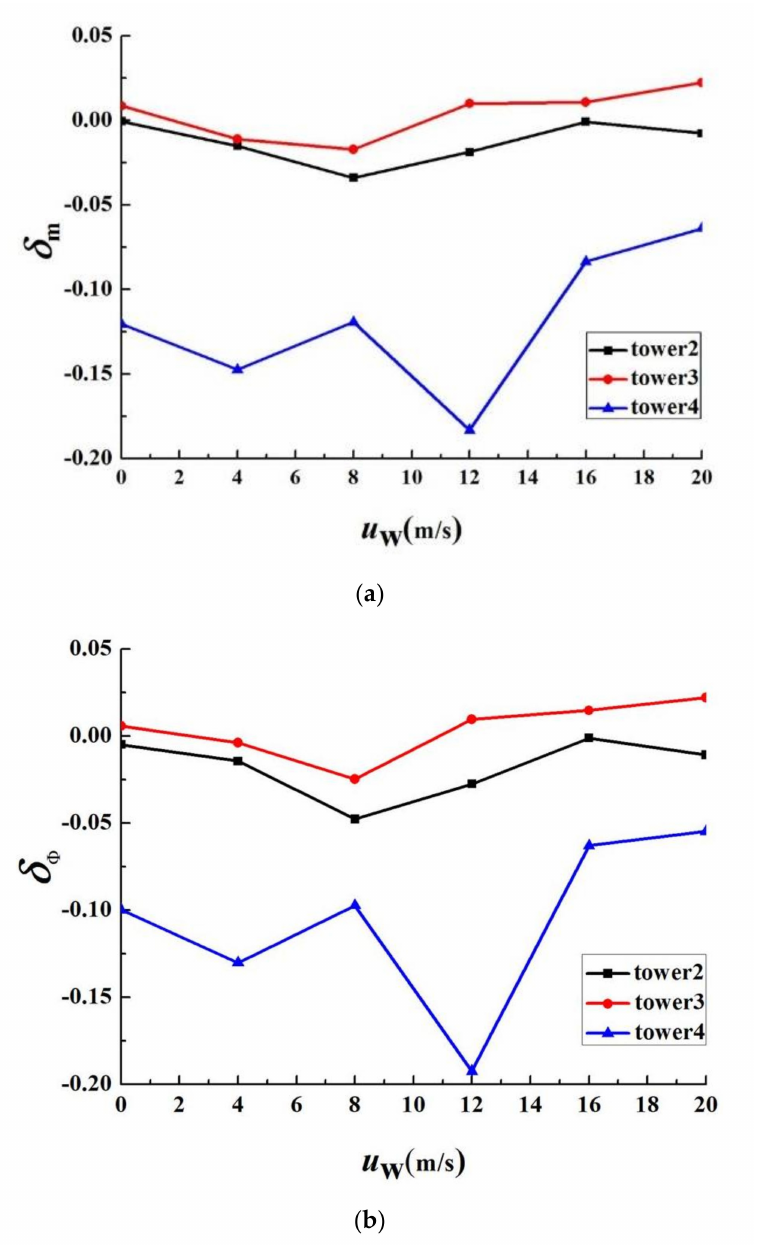
Figure 15. Comparisons of the overall thermal and flow parameters for the four tower